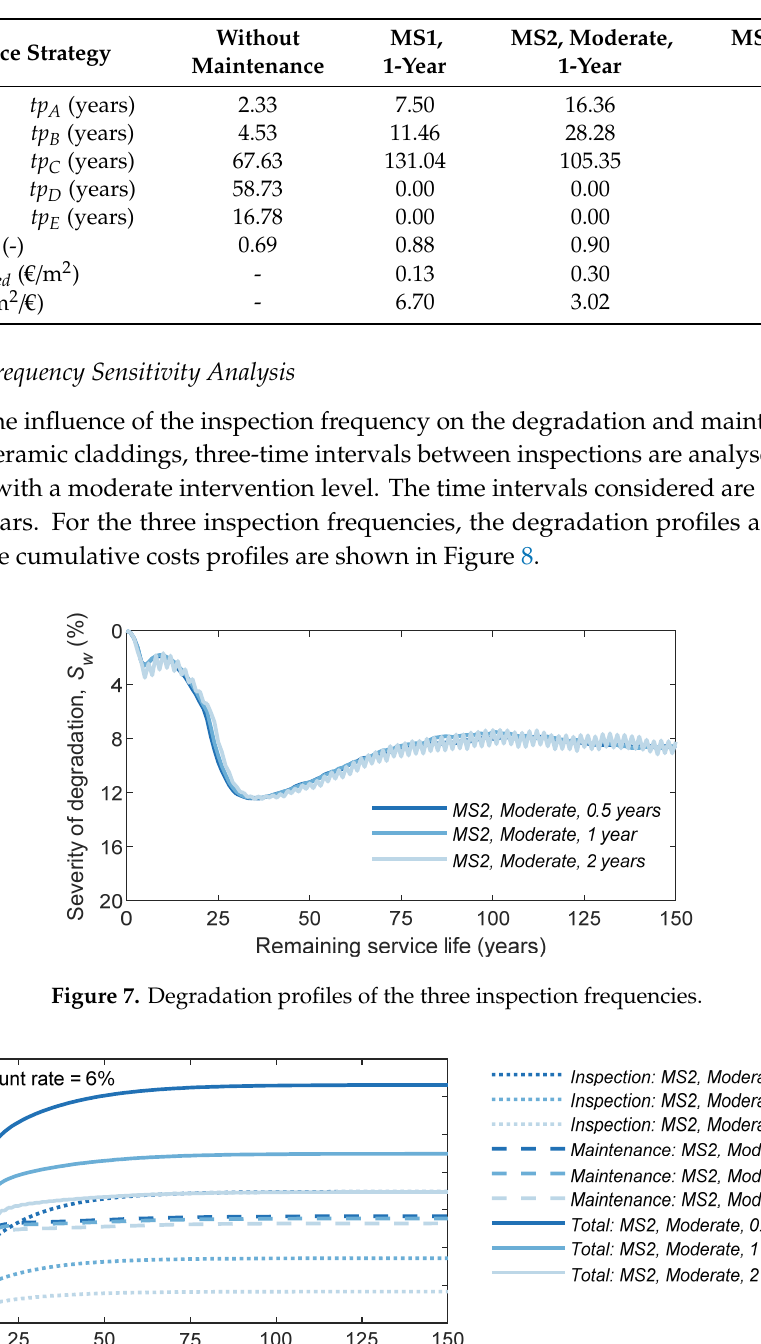
Table 7. E ffi ciency index and the performance indicator of the three maintenance strategies.